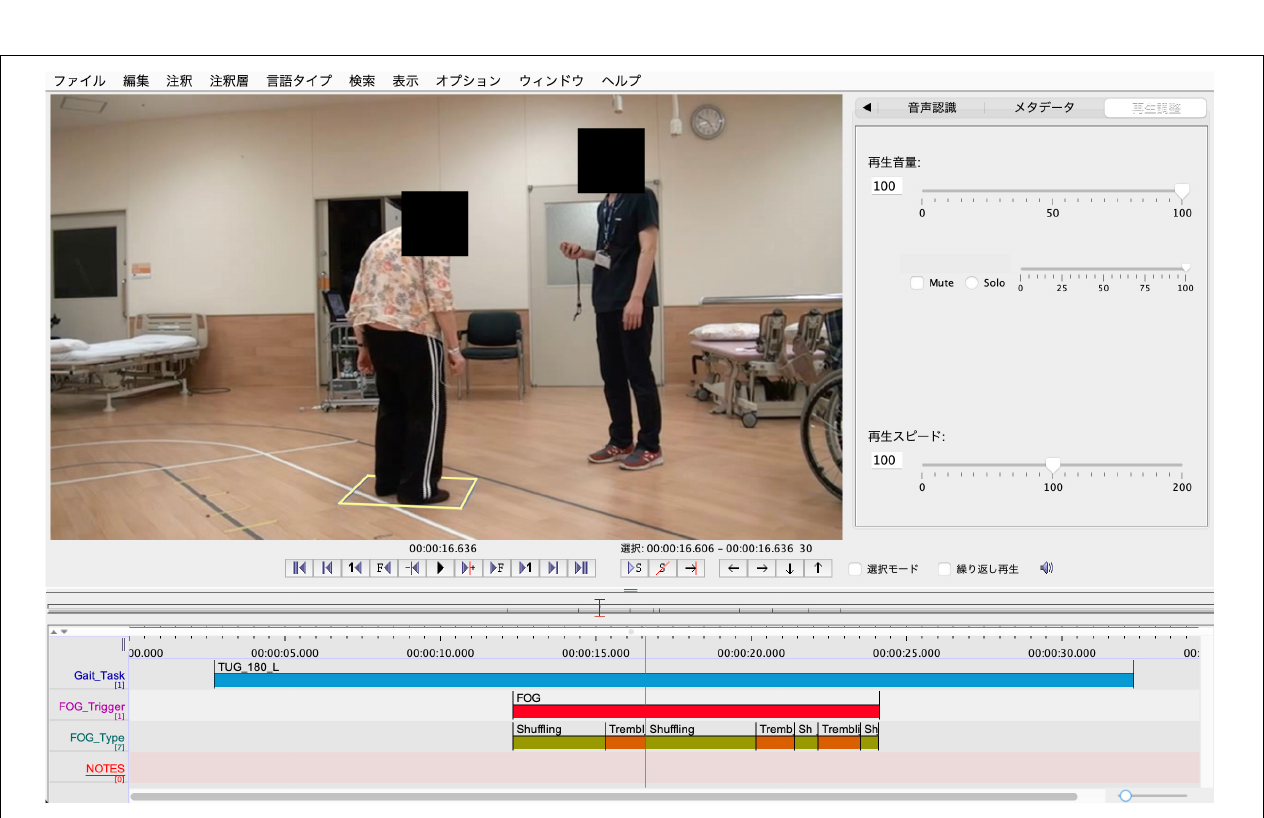
FIGURE 2 | Sample utilizing ELAN. The evaluators watched the video and indicated the total duration of the TUG test (Gait_Tak), FOG (FOG_Trigger), and FOG phenotypes (FOG_Types), resulting in a TUG tag (blue rectangle), FOG tag (red rectangle), and FOG phenotype tag (shuffling = green rectangle; trembling = orange rectangle; complete akinesia = pink rectangle), respectively. These could be resized by dragging the ends horizontally in time by holding down the “option” key. TUG, timed up and go; FOG, freezing of gait.